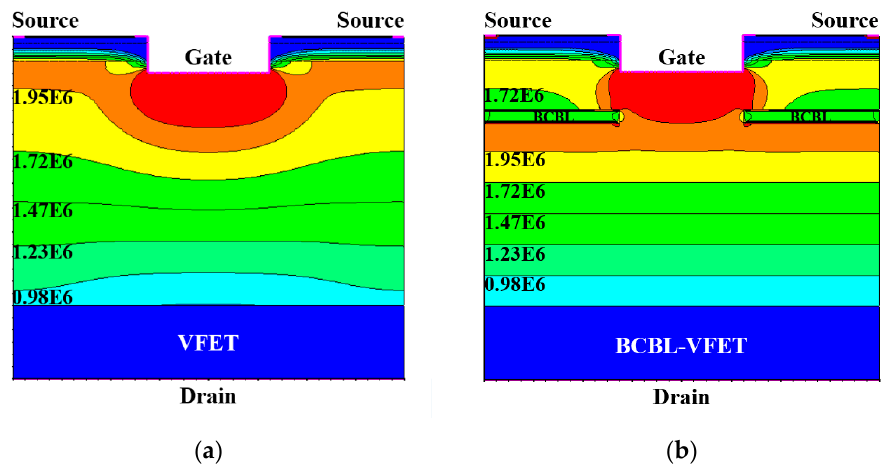
Figure 10. Comparisons of electric field distribution profiles between ( a ) the conventional VFET and ( b ) the proposed BCBL-VFET device.